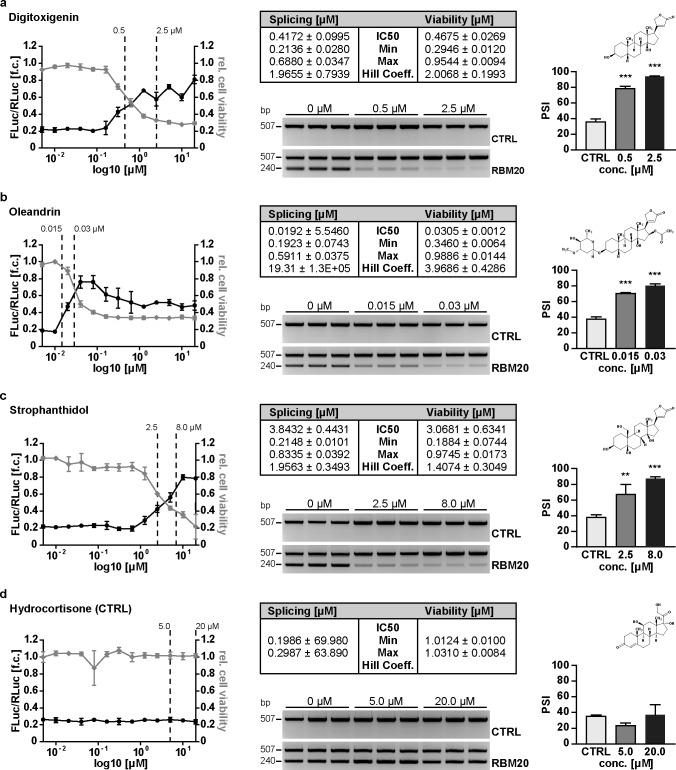
Inhibitors of titin splicing identified by HTS.For each compound concentration dependent activity in the dual luciferase reporter assay and cell viability are plotted. Dashed lines indicate the concentrations used for validation on RNA level. The tables provide kinetic information. Validation by RT-PCR (agarose gel) is quantified by calculating the percent spliced in values (PSI). (a-c) Inhibition of alternative splicing was validated manually in the 96-well format using the DLR assay and conventional as well as quantitative RT-qPCR using an independent genomic minigene derived from TTN exons 241-43 (N = 4). Cardenolides efficiently reduce titin splicing by RBM20 with different potency (splicing IC50). The effect on splicing translates to reduced viability of HEK293 cells (IC50 values splicing vs. viability). (d) The steroid hydrocortisone does not interfere with splicing activity (N = 4). Compared to the cardenolides it lacks the lactone ring at C17 (chemical structures provided on the right). *P<0.05, **P<0.01, ***P<0.001 versus CTRL (Dunnett’s post-test). Data are presented as mean ±SD.